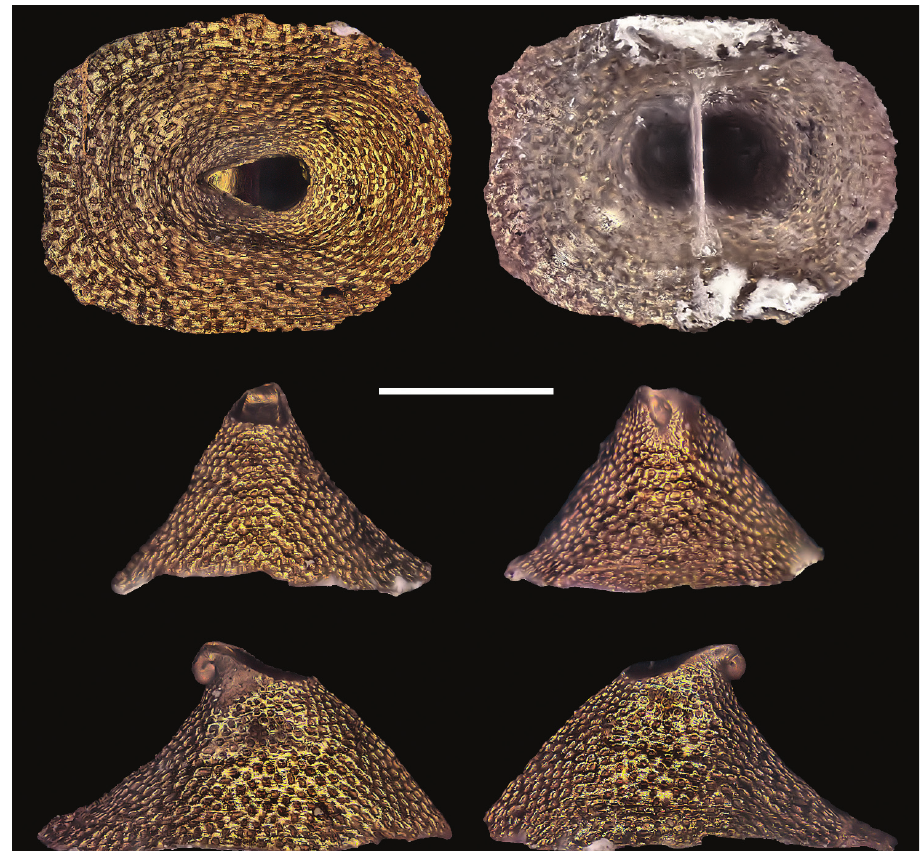
Figure 13. Puncturella ( Puncturella ) voraginosa Herbert & Kilburn, 1986. Holotype T3020/NMSA- MOL 0C1296. Scale bar: 1